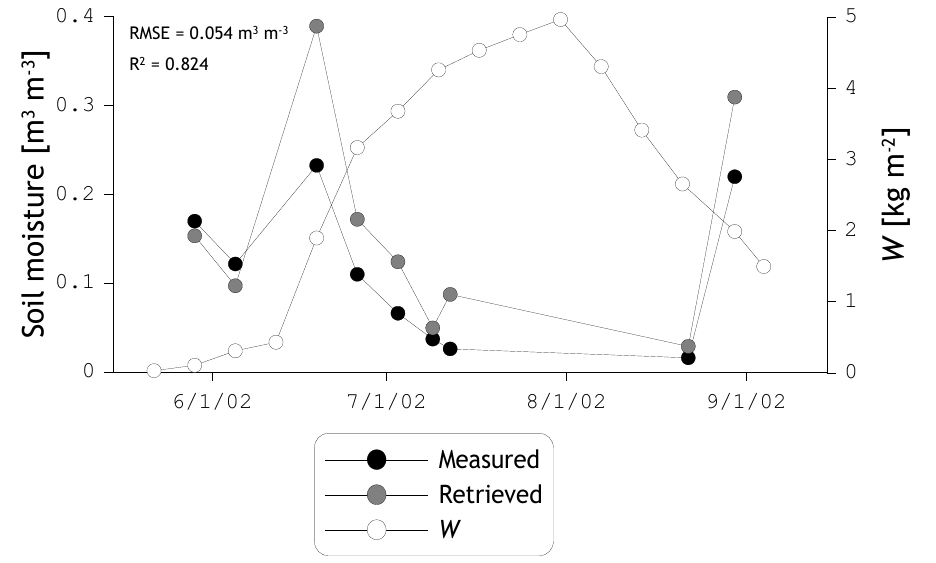
Figure 9. Soil moisture measurements and retrievals obtained by assuming a constant b parameter and ω of 0.12 m 2 kg −1 and 0.0,